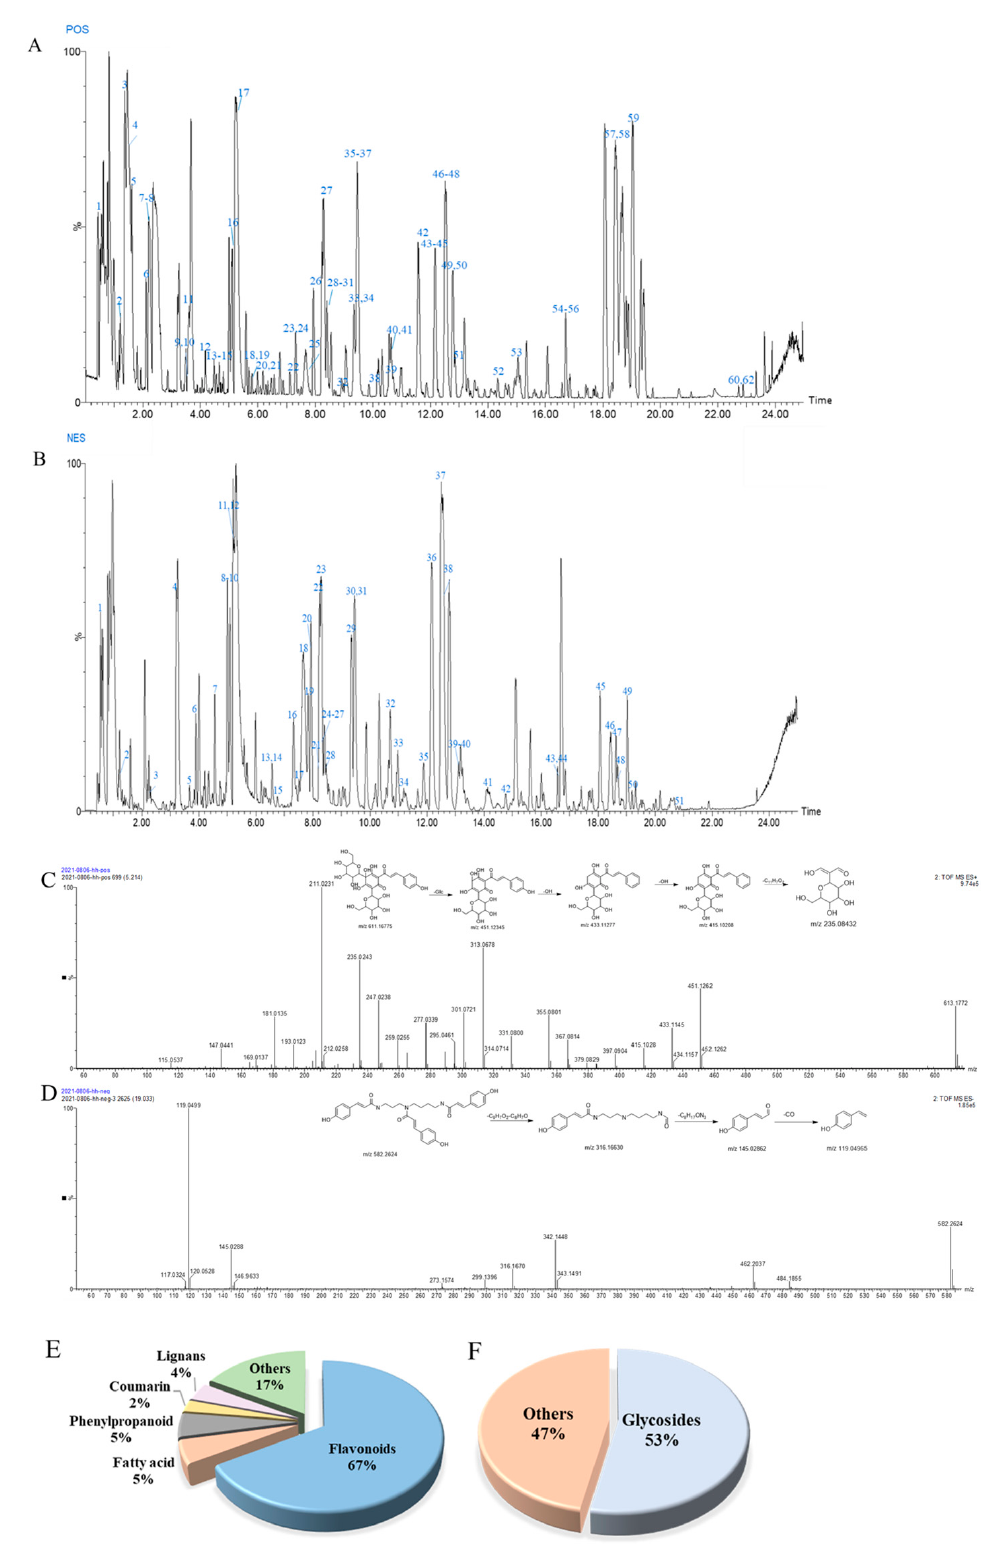
Figure 3. HPLC/QTOF/MS/MS chromatograms of water extracts of safflower in ESI + ( A ) and ESI - ( B ) ion mode. Spectrum information of HSYA ( C ) and N1, N5,N10-(Z)-tri-p-cou-maroylspermidine ( D ) automatically provided by UNIFITM. Structural classification is shown ( E , F